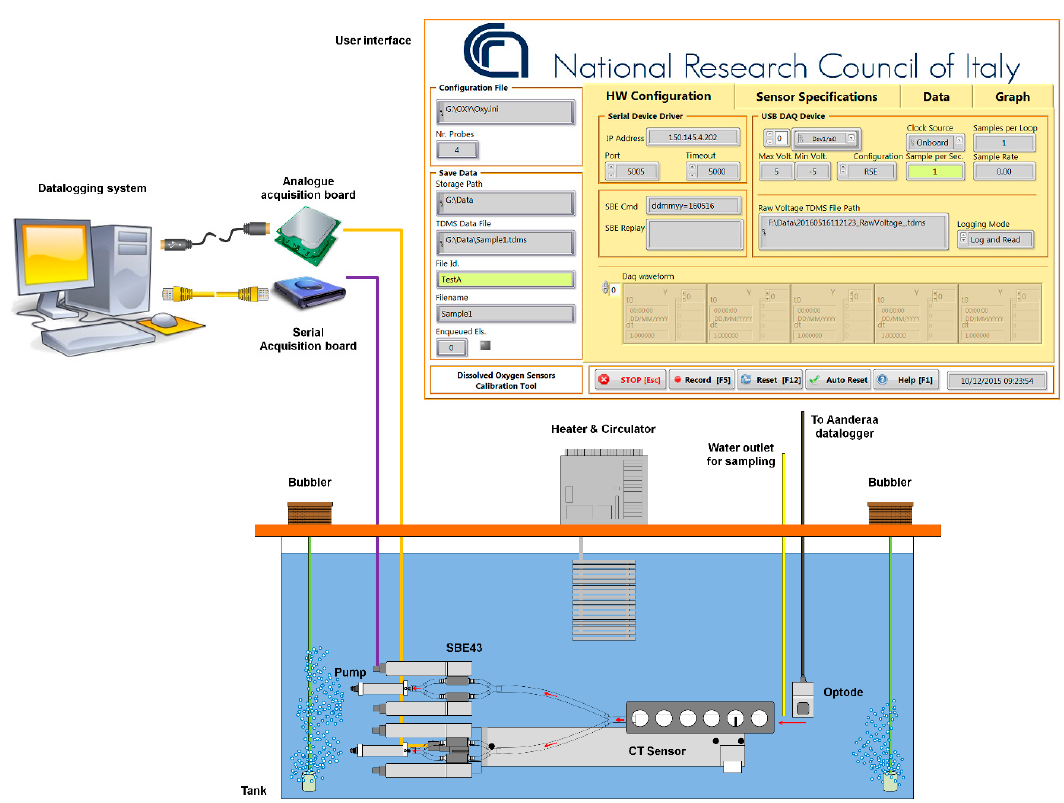
Figure 3. Sketch of the experimental setup used for the intercomparison of the dissolved oxygen sensors and user interface of the developed software